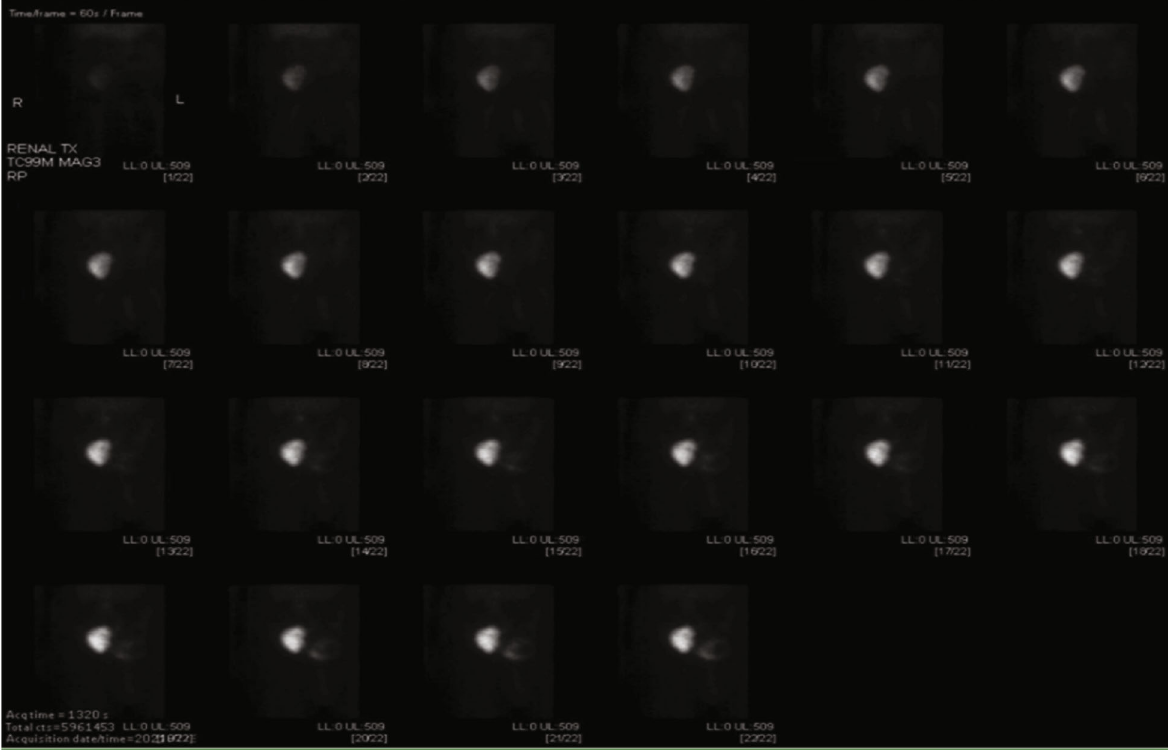
Figure 2: Radionuclide angiogram demonstrates normal blood fl ow to the right lower quadrant transplant. Subsequent renogram images demonstrate cortical retention of radiopharmaceutical without de fi nite excretion with rising renogram curve, suggestive of